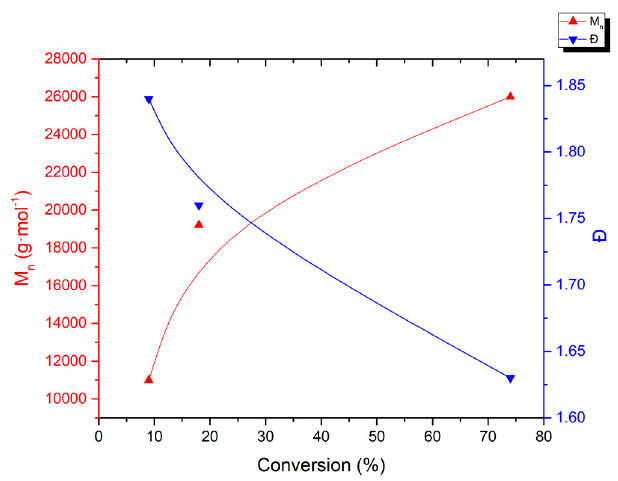
Figure 2. Plots of the number of average molar masses and dispersities vs. conversion of VDF polymerization initiated by UV irradiation in the presence of [Mn(CF 3 )(CO) 5 ].